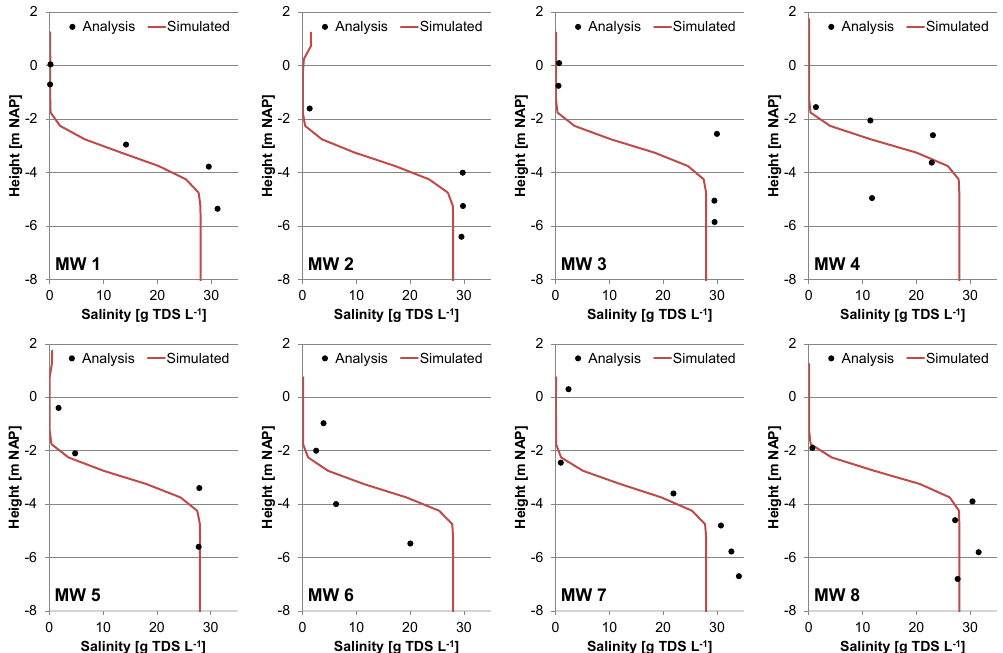
Figure 8. Depth profiles with the observed (black points) and simulated (red line) groundwater salinity in MW 1–8, obtained between 10 and 14 March 2014.